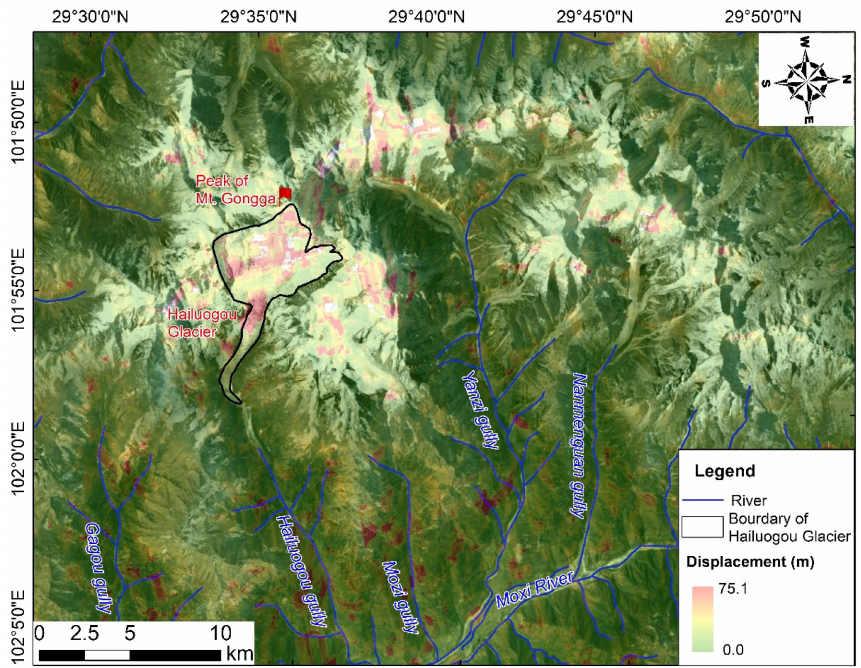
Figure 8. POT deformation result of Sentinel-1 SAR images between 26 August and 7 September